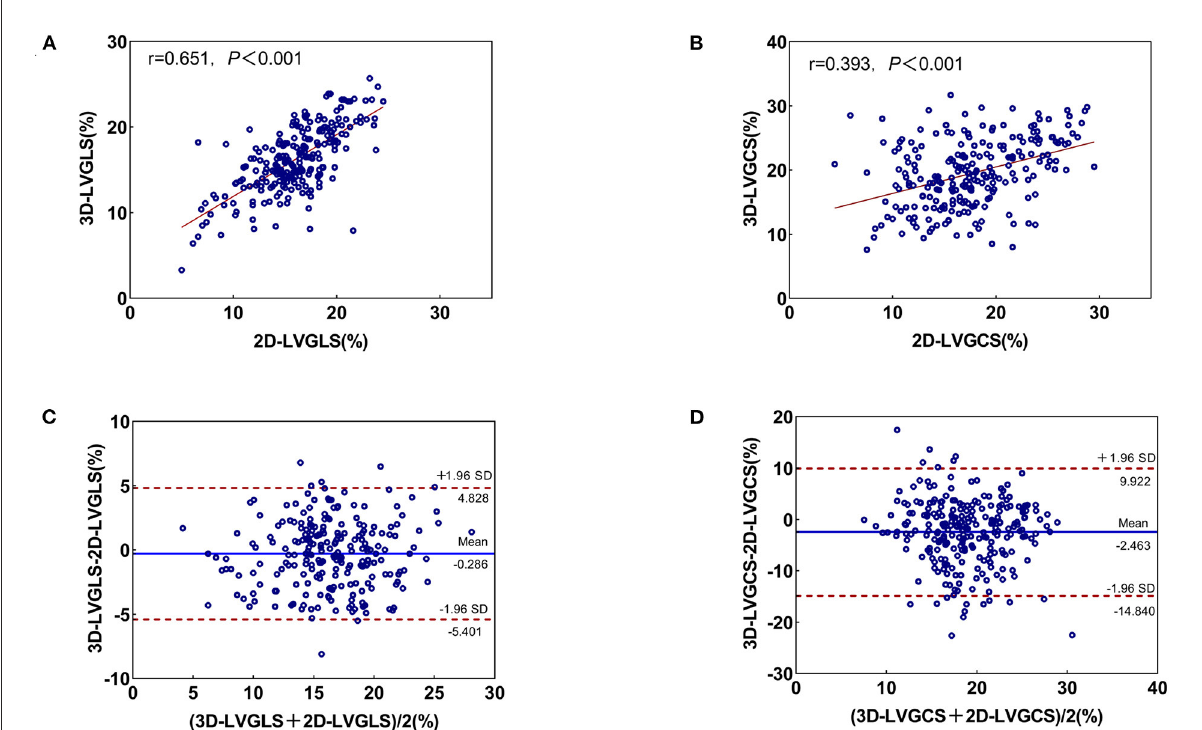
FIGURE3 Correlation and Bland-Altman analysis for 3D- and 2D-STE indices. (A) The correlation between 2D-LVGLS and 3D-LVGLS; (B) The consistency between 2D-LVGLS and 3D-LVGLS; (C) The correlation between 2D-LVGCS and 3D-LVGCS; (D) The consistency between 2D-LVGCS and